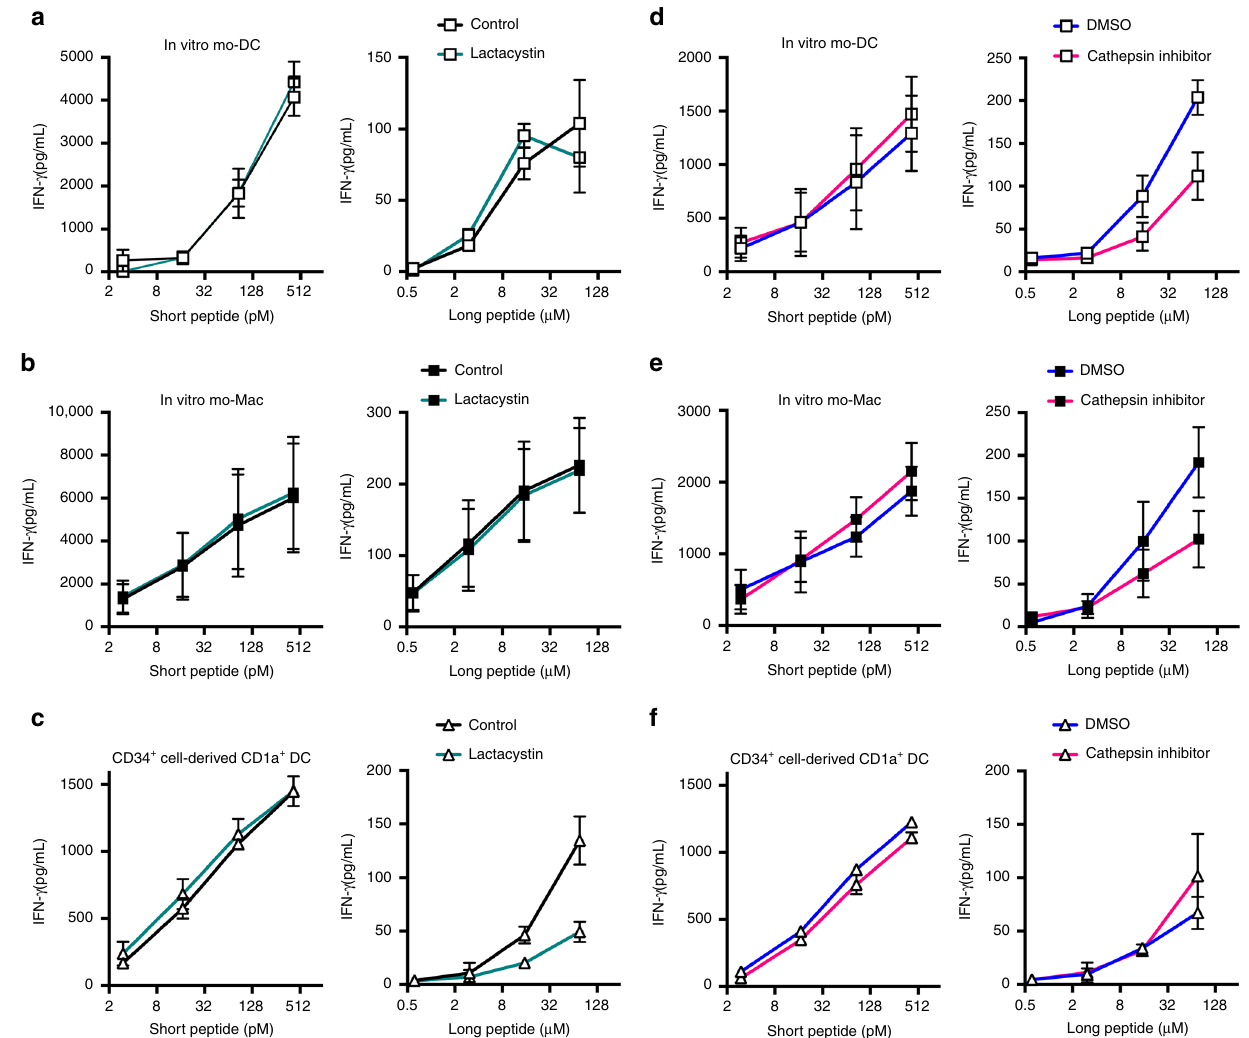
Fig. 5 Human mo-DCs and mo-Mac use the vacuolar pathway for cross-presentation. Puri fi ed in vitro-generated mo-DCs ( a , d ), mo-Mac ( b , e ), or CD34 + cell-derived CD1a + DCs ( c , f ) were incubated with serial concentrations of MelanA long or short peptide, in the absence or presence of lactacystin ( a – c ) or pan-cathepsin inhibitor ( d – f ). After washing, antigen-speci fi c CD8 + T cells were added. After 24 h, IFN- γ secretion was assessed as a measure of T cell activation. Background level was subtracted. Mean± SEM of three ( a ), fi ve ( b , d , e ), or three ( c , f ) independent